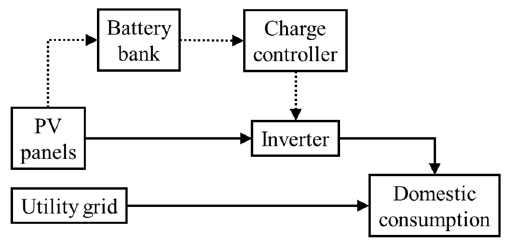
Figure 2. Scheme of a grid-connected domestic PV–battery system.